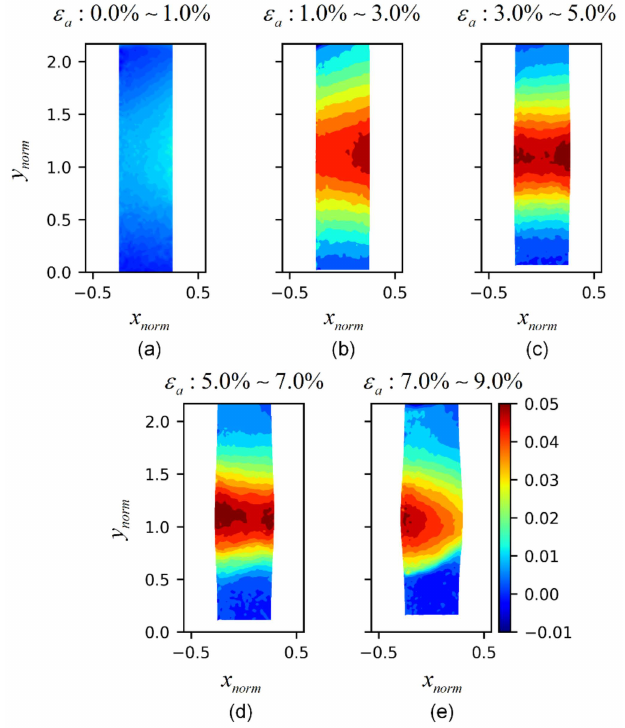
Figure 15. Evolution of gradient along ˆ ρ axis F 11 of test 121304d: ( a ) axial strain 0.0%–1.0%; ( b ) axial strain 1.0%–3.0%; ( c ) axial strain 3.0%–5.0%; ( d ) axial strain 5.0%–7.0%; ( e ) axial strain 7.0%–9.0%.